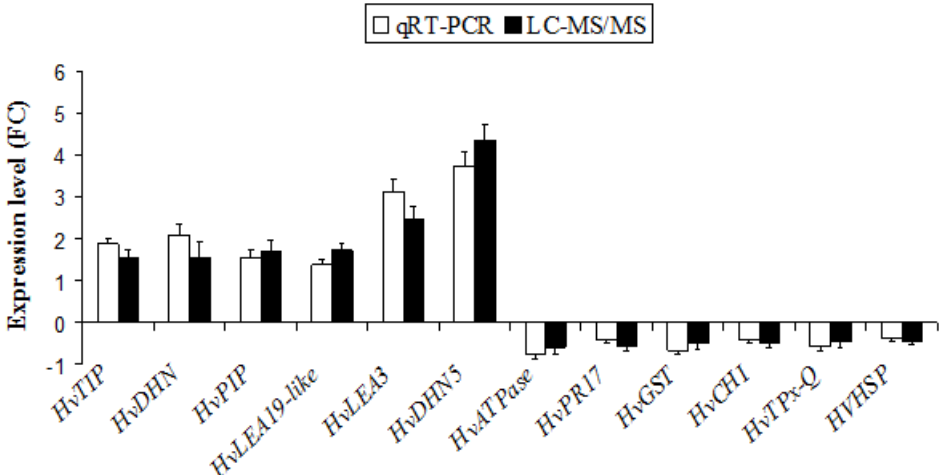
Figure 4. Confirmation of proteomic results by quantitative real-time PCR (qRT-PCR). The white and black bars represent fold change of mRNA and protein abundances in barley roots, respec- tively.